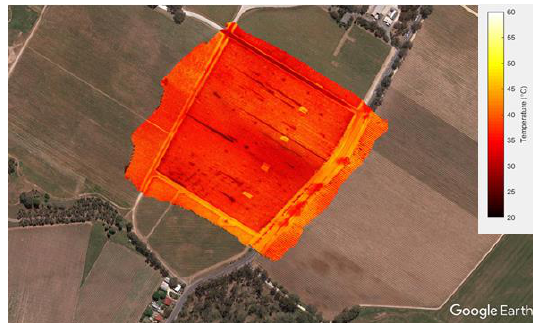
Figure 3: Orthomosaic view of the dense point cloud generated from LWIR thermal imaging